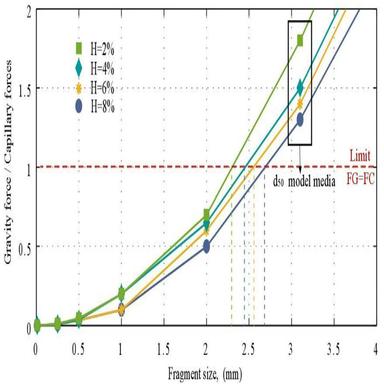
Relation between gravity force (fg) and capillary forces (fc) as a function of fragment size for four moisture contents.